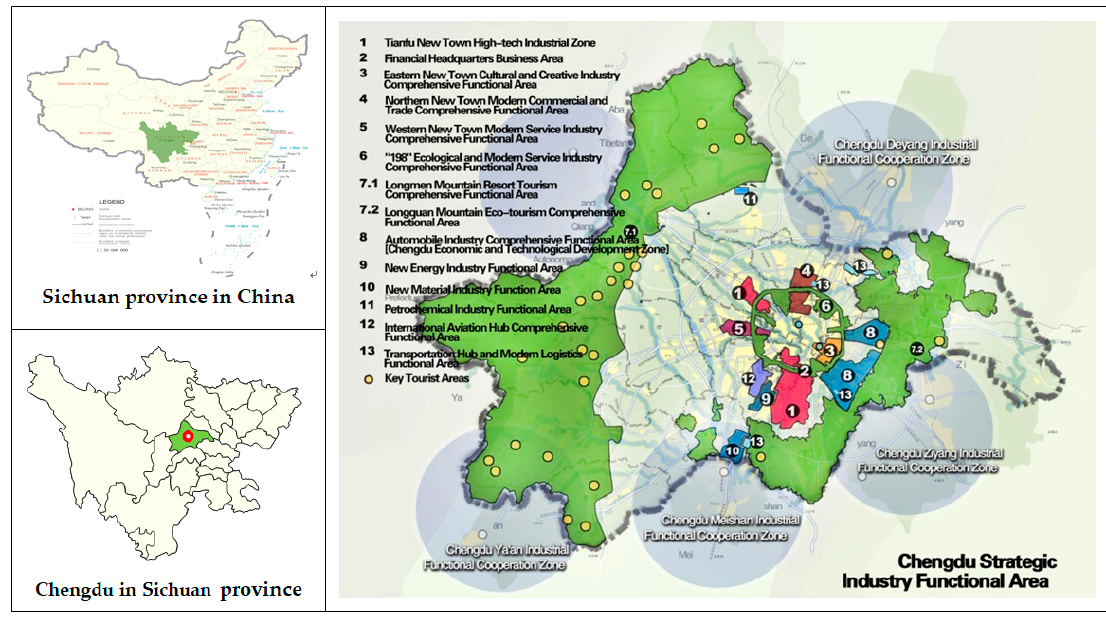
Figure 3. Location of study area.